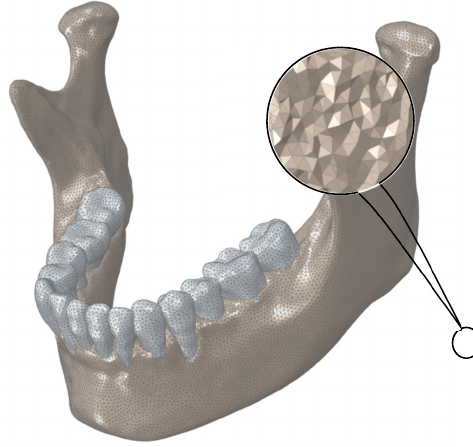
Figure 3. Finite Element mesh for normal mandible. The assigned mesh is 10-node tetrahedral elements (C3D10).